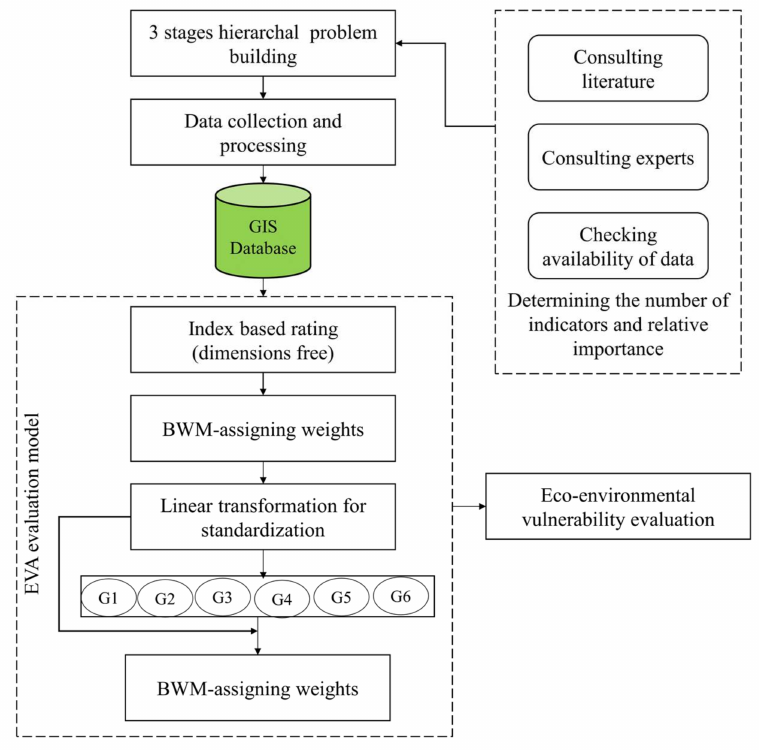
Figure 4. The adopted methodology for eco-environmental vulnerability assessment of CPEC